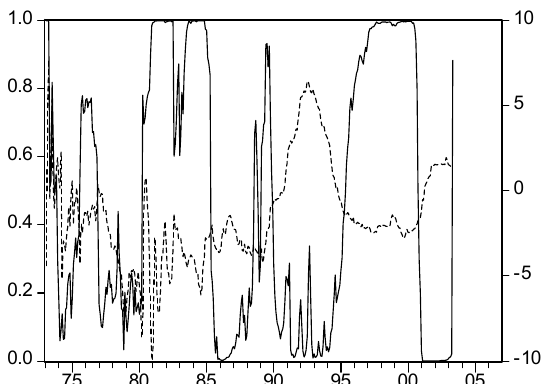
Figure 4. Regime probability and interest rate differential. Note: Bold line: the ex ante probability P(s t = 1 | Ω t − 1 ) of being in the bubble regime for the extended model (left axis); dotted line: the interest rate differential i t -i* t (right axis).